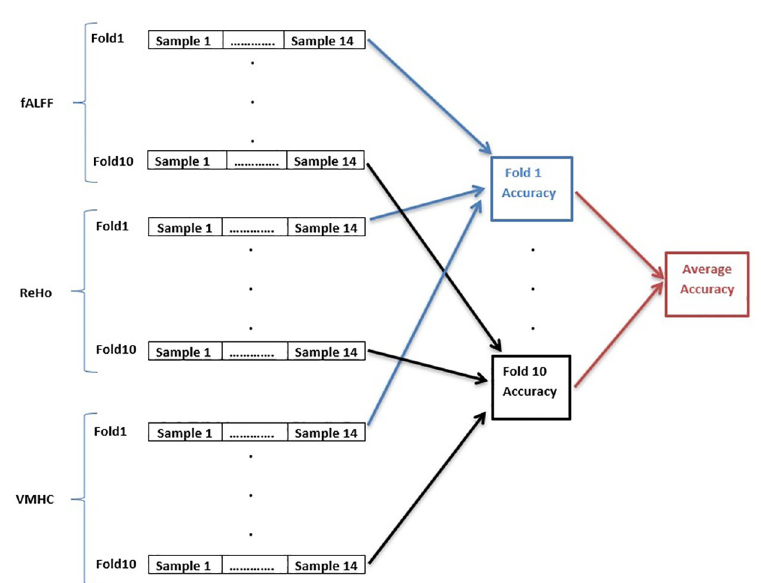
Fig 3. ROC curves for schizophrenia classification using different feature combinations and ROC vertical averaging where the numbers in brackets denote the area under the curve (AUC): (a) Single feature types. (b) Pairwise feature type combinations. (c) Triple and quadruple combinations of